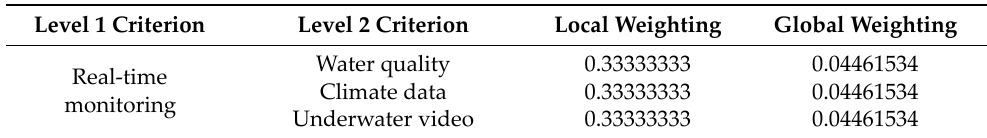
Table 9. Level 2 priority evaluation results for Level 1 ‘real‑time monitoring’ criterion using the modified AHP.